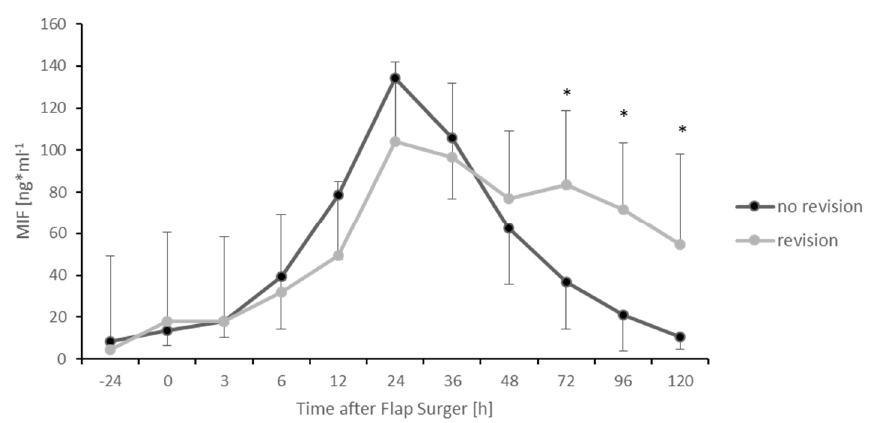
Figure 4. Postoperative MIF levels divided into two groups. Subjects that needed surgical revision due to thrombosis of the microanastomosis (grey) and subjects without surgical revision (black). Error bars refer to the corresponding standard deviations (* p ≤ 0.05).